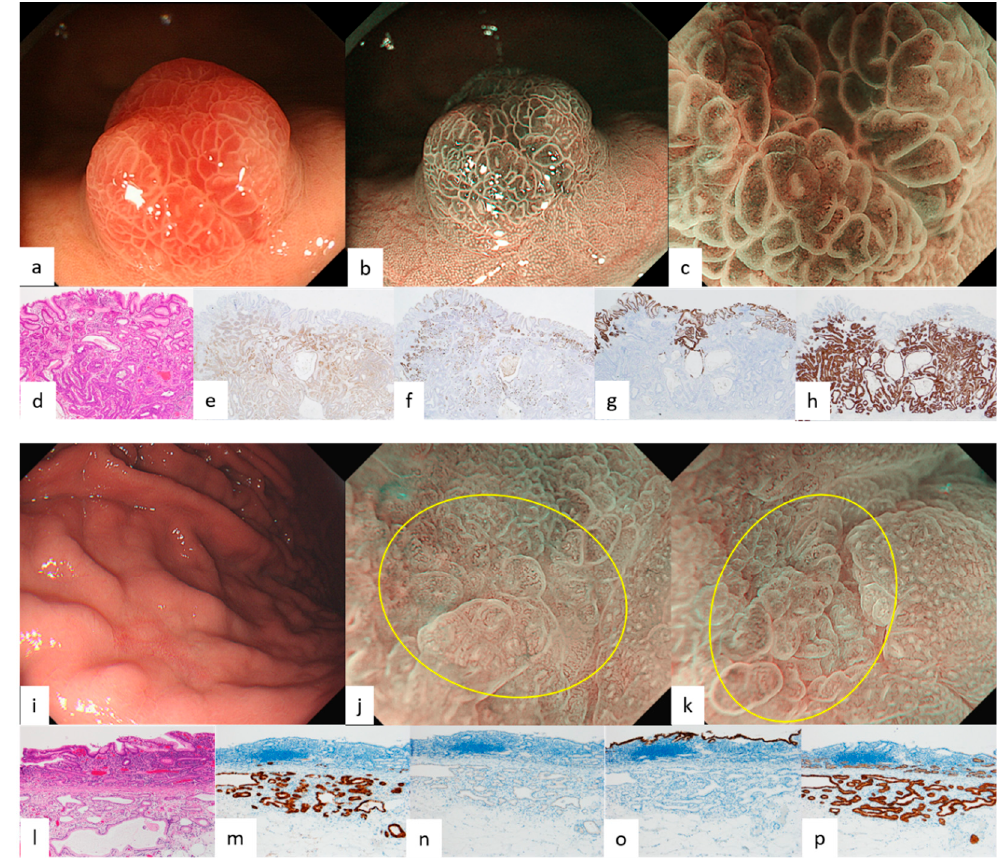
Figure 2. Endoscopic and pathological findings of GA-FG (reddish elevated type, reddish flat or depressed type). ( a ) WLI. An intensely reddish (partially normal-colored) elevated lesion, 12 mm in size, was found in the greater curvature of the gastric fundus. Atrophic changes in the background mucosa, SMT shape, and dilated vessels with branching architecture were not noted; ( b , c ) M-NBI. Microvessels without distinct irregularity were found in the dilated IP bordered by arcuate MCE. A regular MV pattern plus regular MS pattern without a DL were observed by the MESDA-G; the lesion was diagnosed as non-cancerous; ( d ) HE stain. Tumor cells similar to chief cells proliferated primarily in the deep mucosa, with the surface layer being covered by non-neoplastic mucosa; ( e – h ) Immunostain; ( e ) pepsinogen-I (chief cell). Diffusely positive; ( f ) H+/K+-ATPase (parietal cell). Partially positive; ( g ) MUC5AC (gastric foveolar epithelial cell). Negative; ( h ) MUC6 (gastric mucous neck cell). Diffusely positive; Final pathological diagnosis: U, type 0-I, 12 mm, gastric adenocarcinoma of fundic gland type, pT1b/SM1 (200 μ m), UL0, Ly0, V0, HM0, VM0. ( i ) WLI. A slightly reddish (partially normal-colored) depressed lesion 18 mm in size was found on the posterior wall of the greater curvature of the upper gastric body. Atrophic changes in the background mucosa, distinct borders, and dilated vessels with branching architecture in the surface layer were not noted; ( j , k ) M-NBI. There was no distinct DL, and an irregular MS pattern and dilatation of CO and IP were observed. As for an MV pattern, some microvessels showed irregularity, while others did not show any distinct irregularity. An irregular MV pattern plus irregular MS pattern without a DL were (yellow circle) observed by the MESDA-G; the lesion was diagnosed as non-cancerous. ( l ) HE stain (border of lesion). Tumor cells similar to mucous neck cells or chief cells proliferated primarily in the deep mucosa. The tumor extended laterally and also invaded the submucosal layer. The surface layer was covered by non-neoplastic mucosa with inflammatory cell infiltration and vascular proliferation, suggesting that the difference in height between the lesion and the background mucosa was generated by replacement of the normal fundic gland by the tumor. The tumor cells invaded up to 400 μ m; ( m – p ) Immunostain; ( m ) pepsinogen-I (chief cell). Diffusely positive; ( n ) H+/K+-ATPase (parietal cell). Negative; ( o ) MUC5AC (gastric foveolar epithelial cell). Negative; ( p )